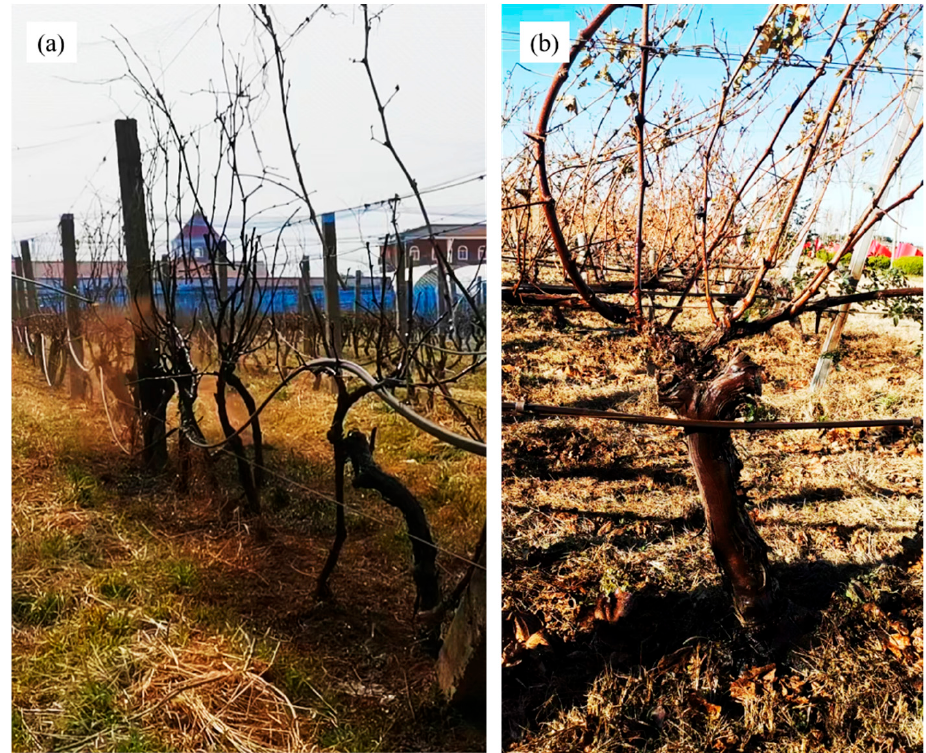
Figure 2. Biodegradable liquid film (BLF) spraying treatment: spraying operation ( a ) and three months after spraying ( b ).